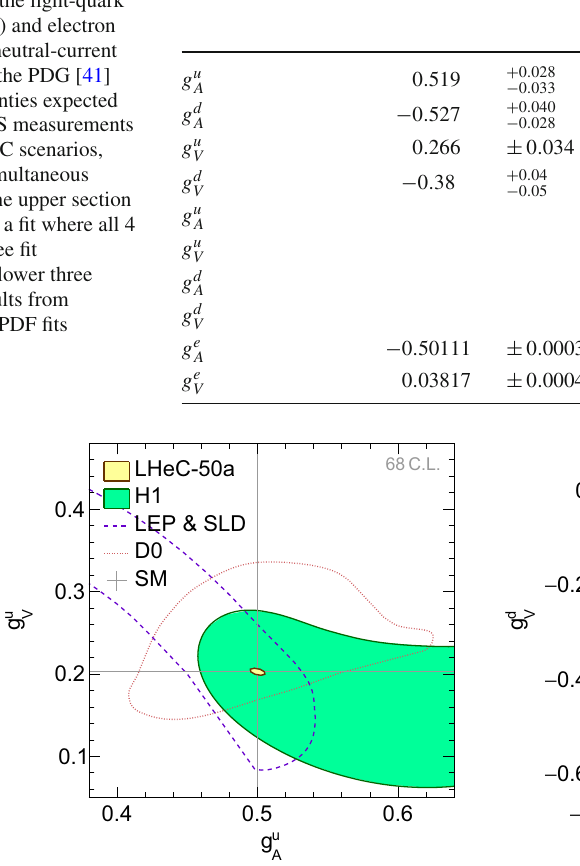
uncertainties of the light-quark ( g u , g d , g u , g d ) and electron A A V V ( g e , g e ) weak neutral-current A V couplings from the PDG [41] and the uncertainties expected for inclusive DIS measurements in different LHeC scenarios, obtained in a simultaneous EW+PDF fit. The upper section shows results of a fit where all 4 couplings are free fit parameters, the lower three sections are results from two-parameter+PDF fits